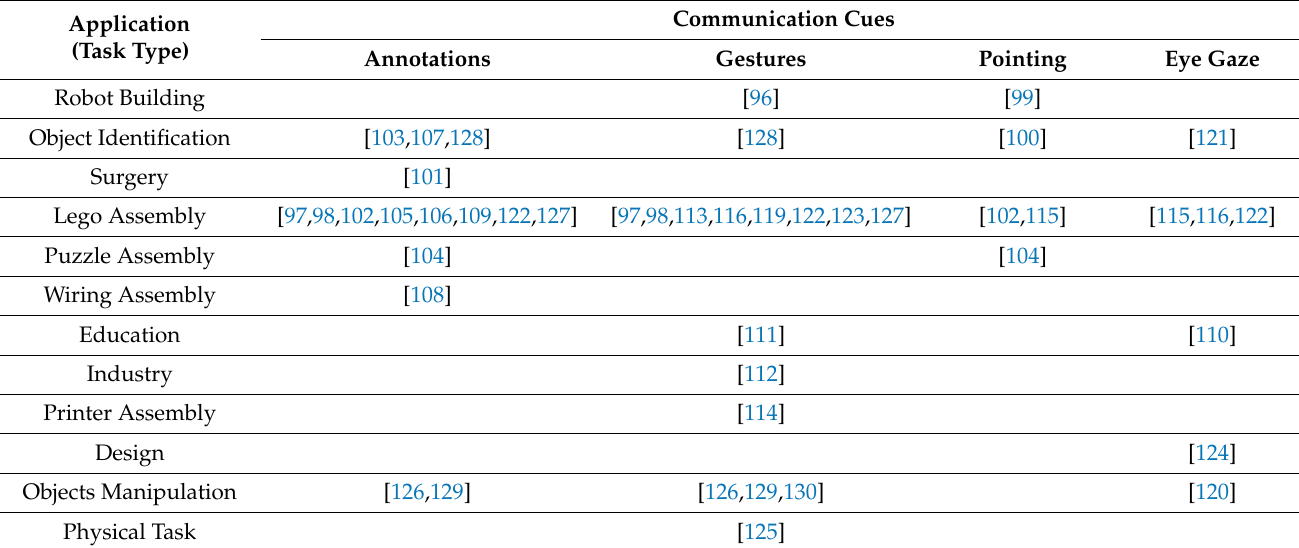
Table 3. Communication cues.